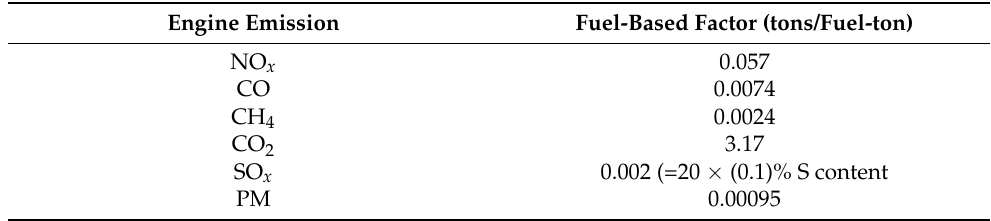
Figure 21. The WTT environmental impacts of marine fuel vs. different nations. For the TTW, given that the ship’s lifespan is 30 years, the lifetime fuel consumption of the case ships was estimated based on their current operating profile and fuel records. The emissions from the fuel consumption are further estimated in Table 9. Table 9. Emission factors as engine fuel